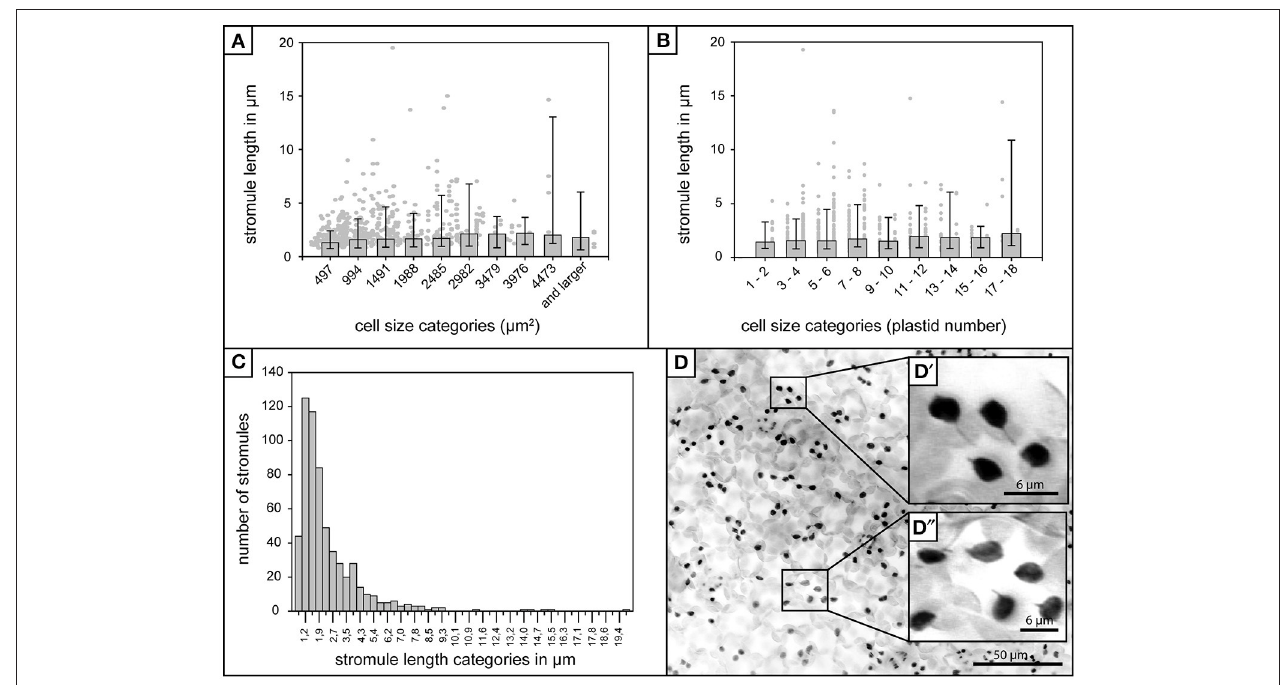
FIGURE 1 | Stromule length in A. thaliana rosette leaf upper epidermis. (A) Foreground—Bars represent median stromule length for all cell size categories where cell size is expressed in µ m 2 ( n = 603). Background—Individual stromule length measurements. (B) Foreground—Bars represent median stromule length for all cell size categories where cell size is expressed in plastids per cell (same data set as in A ). Background—Individual stromule length measurements in each category. (A,B) Error bars represent 10th and 90th percentiles. (C) Histogram of stromule length measurements observed over all cell sizes. (D) Z-stack of A. thaliana upper epidermis expressing FNRtp:eGFP labeling plastids and stromules (converted to grayscale and inverted to increase clarity). Scale = 50 µ m. (D ′ ) and (D ′′ ) insets show examples of several typical short stromules as well as several plastids without stromules (Scale = 6.25 µ m).